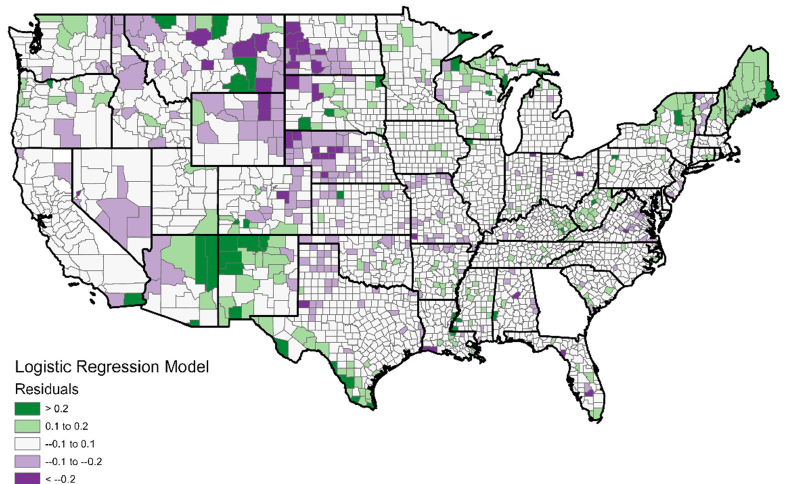
Figure 5. Residuals from logistic regression model. Green indicates vaccination rates were higher than expected; purple indicates vaccination rates were lower than expected. Figure 5 indicates some spatial clustering in the model residuals. There is a cluster of positive residuals (modeled vaccination rates higher than reality) in areas from the north- ern Great Plains; these are extremely isolated rural areas that are mostly white and polit- ically conservative. Because of the sparse, isolated nature of the population there, limiting the opportunities for viral spread, residents may feel that COVID-19 mitigation is not a priority in their lives. Several clusters of negative residuals (real vaccination rates higher than modeled) are also apparent. One, in the Southwest, consist of rural counties which are inhabited mostly by Native Americans (for the AZ/NM counties) or Hispanics (for the counties along the TX border). What we are seeing here appears to be racial/ethnic minor- ities adopting the vaccine at higher rates than would be expected based on their lifestyle classifications. Additionally, looking closely at other parts of the West such as the Dakotas and Montana, counties which contain Native American reservations have higher than